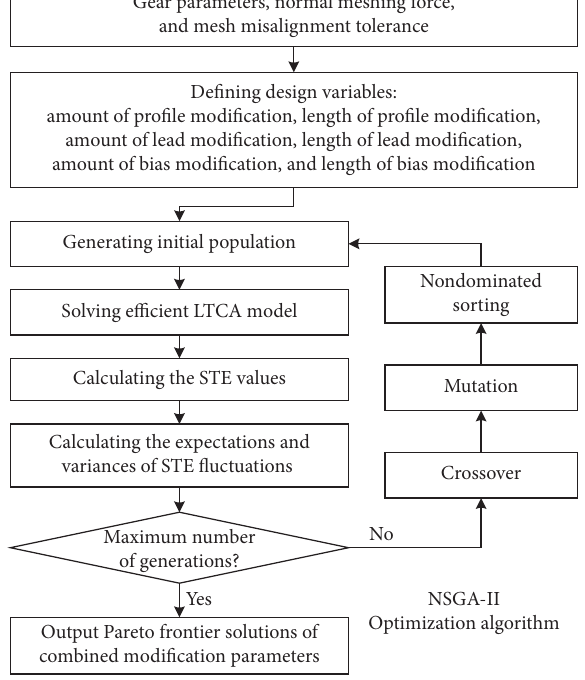
Figure 8: Multiobjective optimization model of combined tooth surface modification.